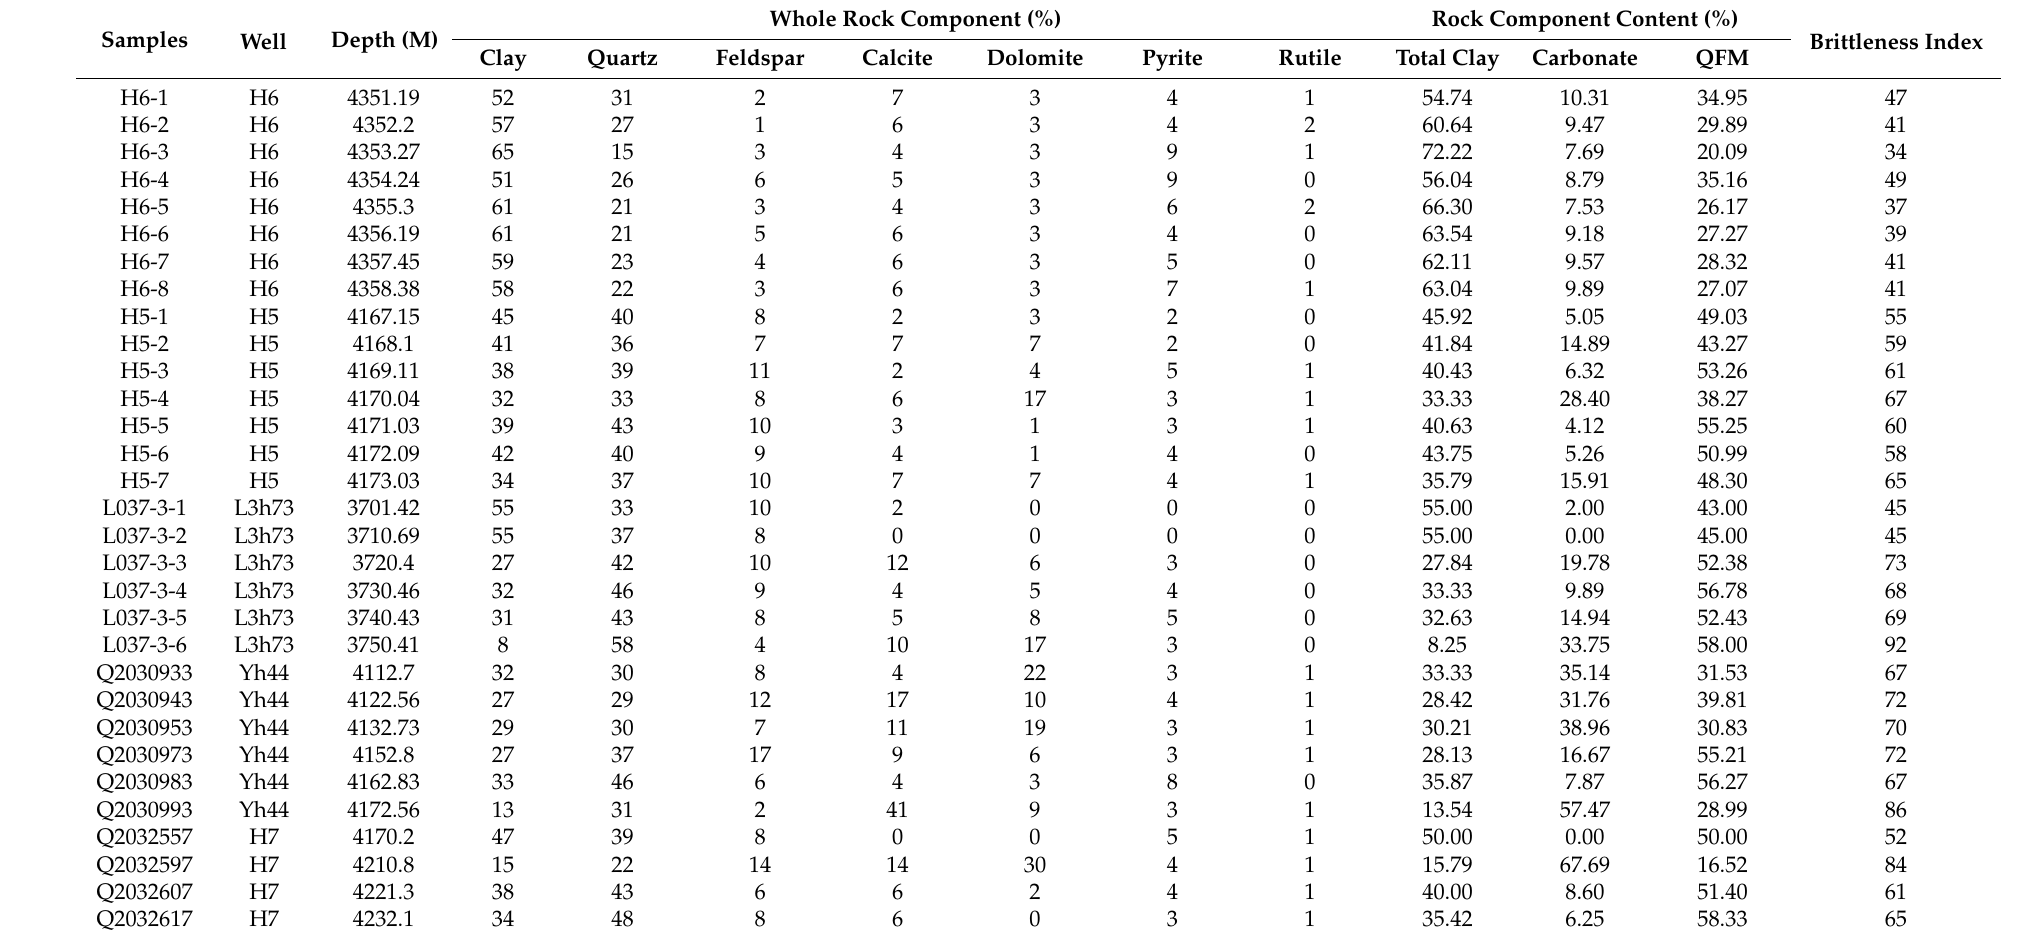
Table 2. Mineralogical characteristics of shale in the Longmaxi